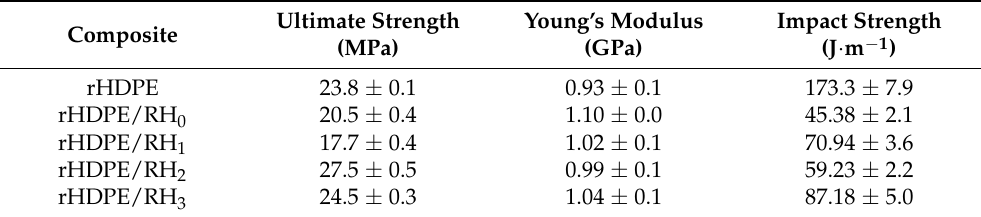
Table 5. Tensile and impact properties of rHDPE and reinforced composites.